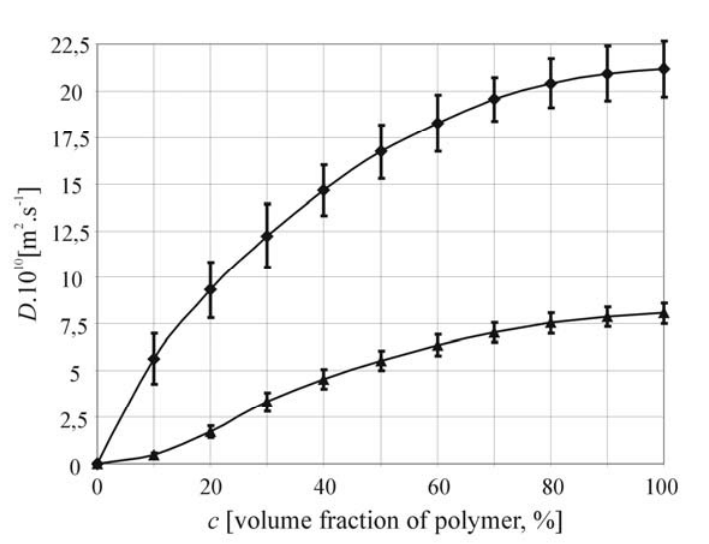
= 50.28 kDa and triangles-M = 1377 kDa). w w